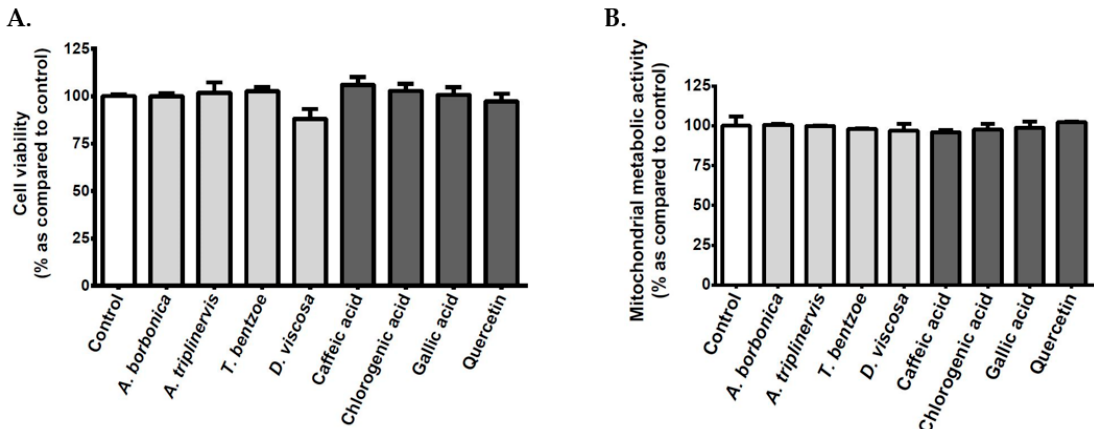
Figure 2. Effect of polyphenols on the viability and mitochondrial metabolic activity of cerebral endothelial cells. Cells were exposed to normoglycemic condition in presence or not of each polyphenol-rich plant extract (10 µ M GAE) or standard polyphenol (10 µ M) for 24 h. In order to evaluate the cellular viability, the cells were counted by using the Trypan blue exclusion method ( A ). The mitochondrial metabolic activity was determined by the 3-(4,5-dimethyl-thiazol-2-yl)-2,5-diphenyl tetrazolium bromide (MTT) assay ( B ). Data are means ± SEM of three independent experiments.